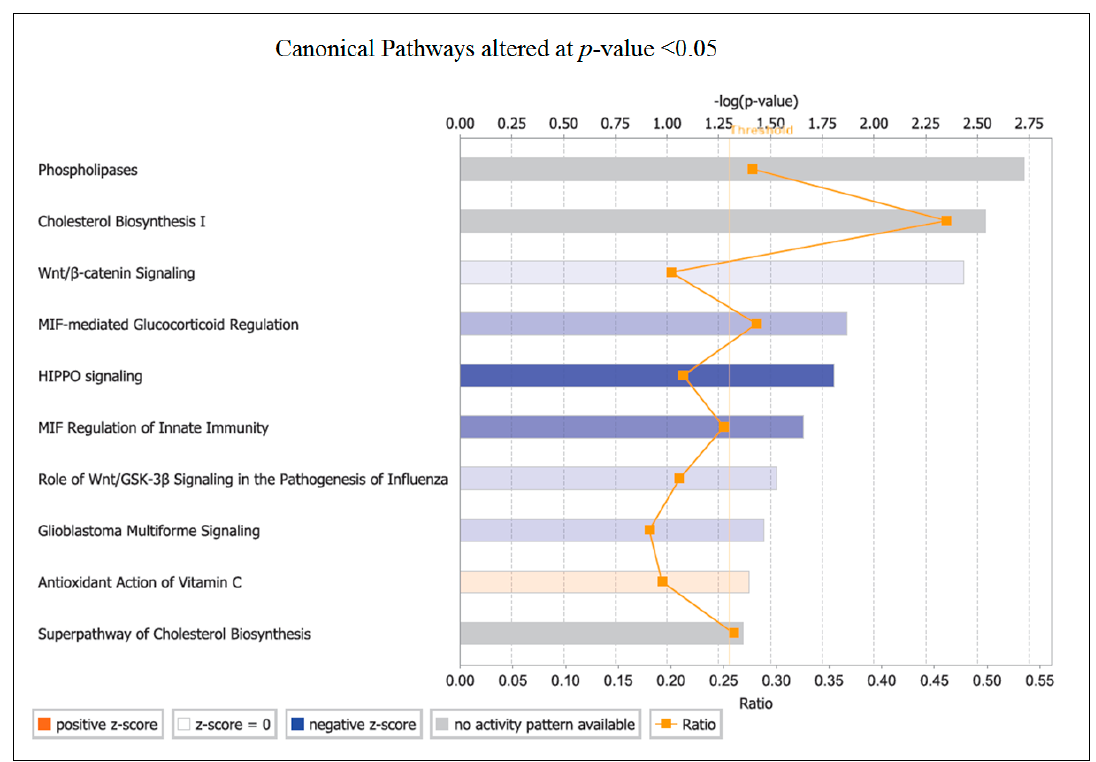
Figure 2. Canonical pathways affected after OLE supplementation under the criteria p < 0.05. A positive z-score (orange) indicates that gene expression is upregulated, while a negative score (blue) represents downregulated expression. The grey bars contain genes that are up and downregulated; therefore, the activity pattern cannot be determined. Ratio is the number of genes from a pathway that were altered with OLE consumption. The p -value for each pathway is presented on a log scale to allow easier visualisation.